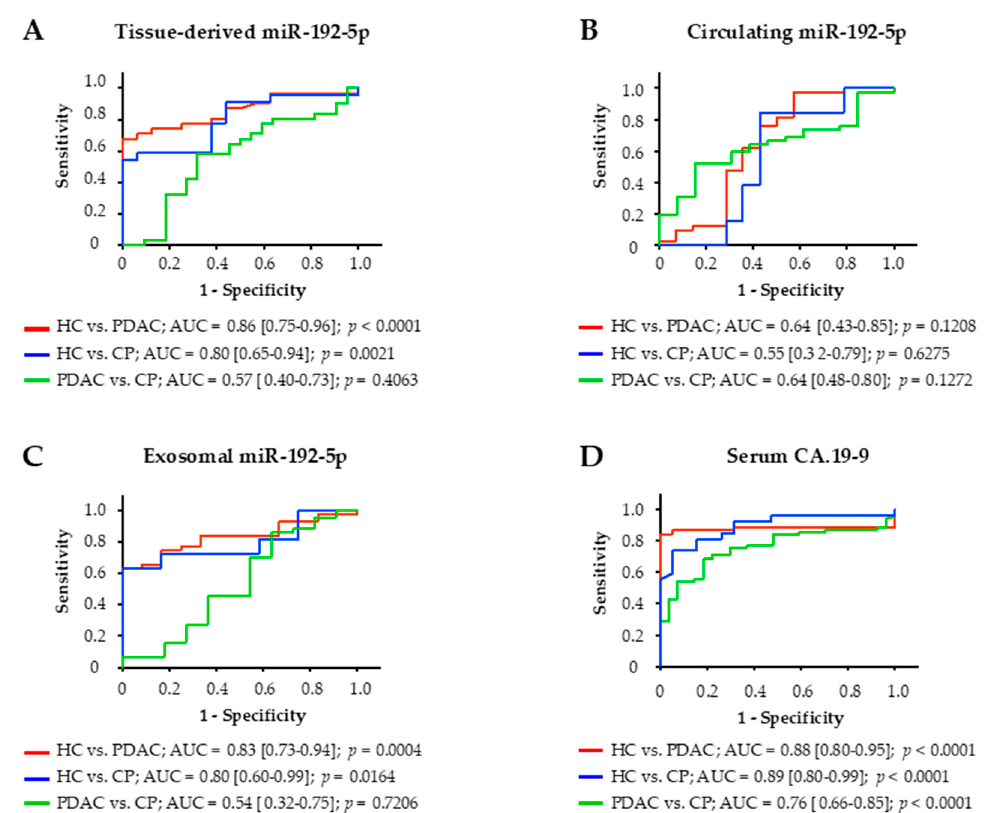
Figure 4. Receiver operating characteristic (ROC) curve analysis for diagnostic potential of miR-192-5p in ( A ) tissue, ( B ) serum, ( C ) serum exosomes, and for ( D ) carbohydrate antigen 19.9. AUC, area under the ROC curve; CP, chronic pancreatitis; HC, healthy controls; PDAC, pancreatic ductal adenocarcinoma.